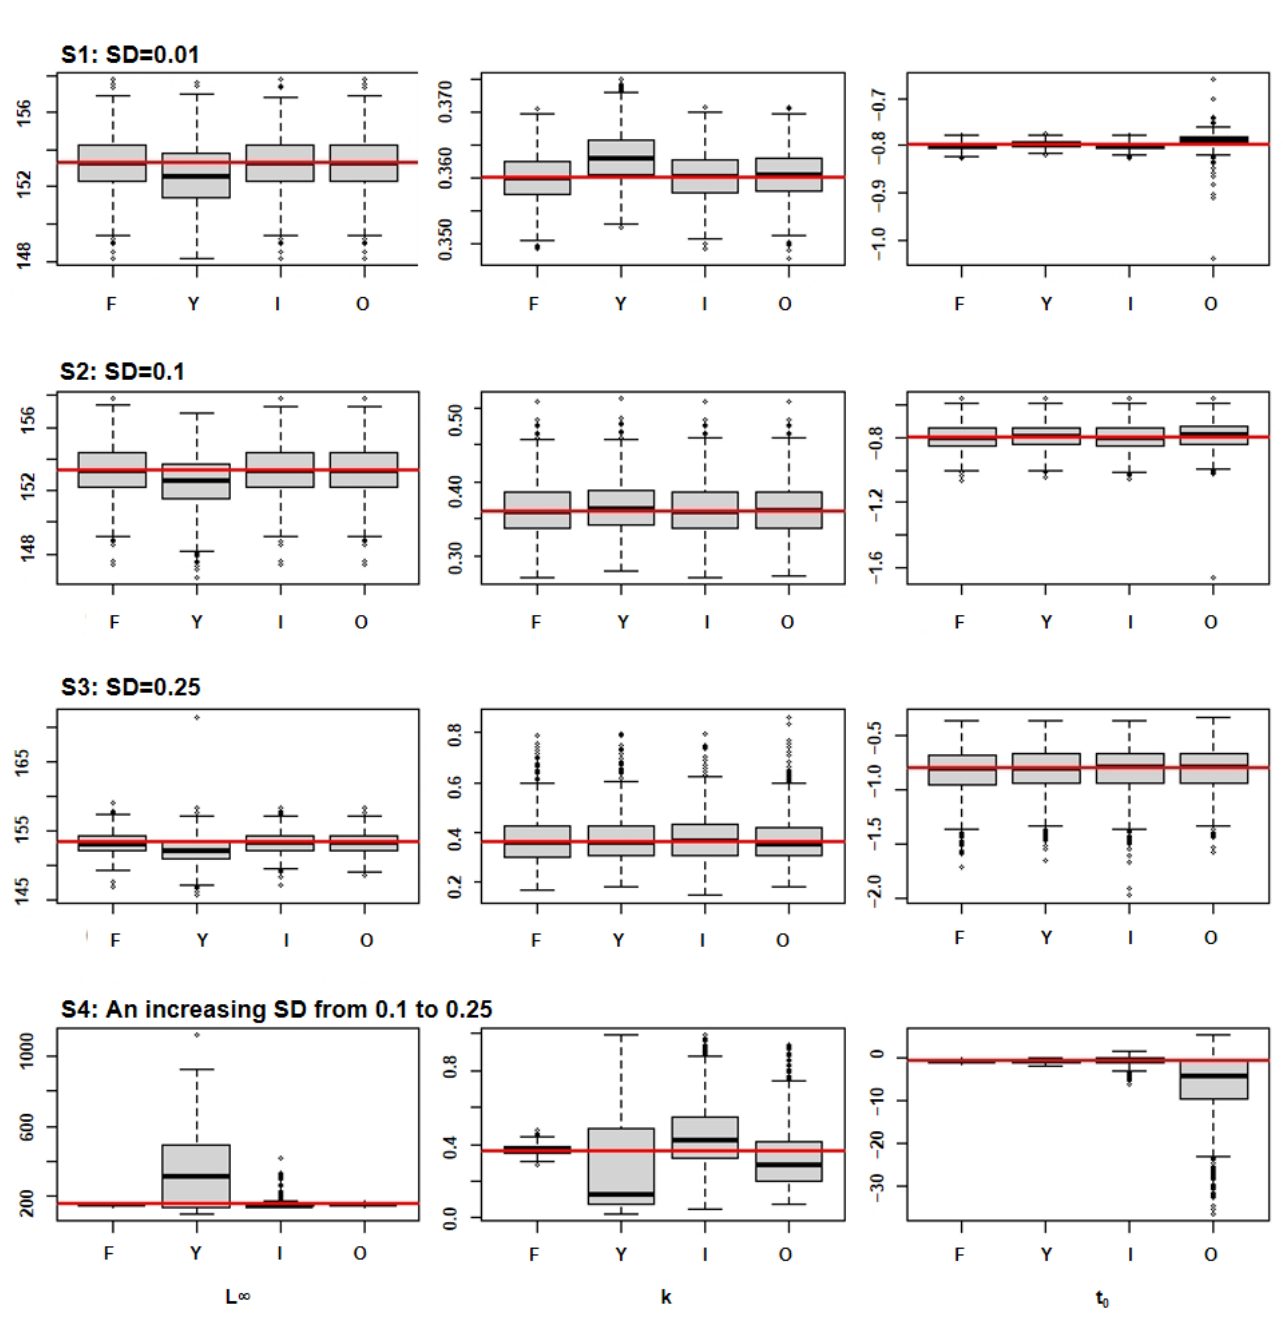
Figure 5. Distributions of estimated growth parameters of simulated yellowfin tuna (the red line is the initial parameter; L ∞ , k and t 0 are three parameters in the Von Bertalanffy growth model).